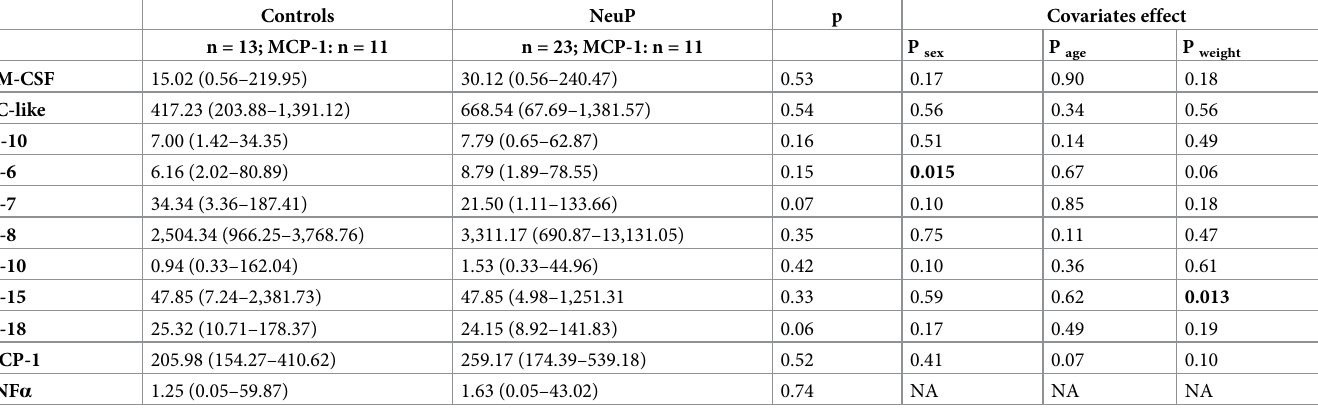
NA = Data non available (nonparametric test). Data in bold are